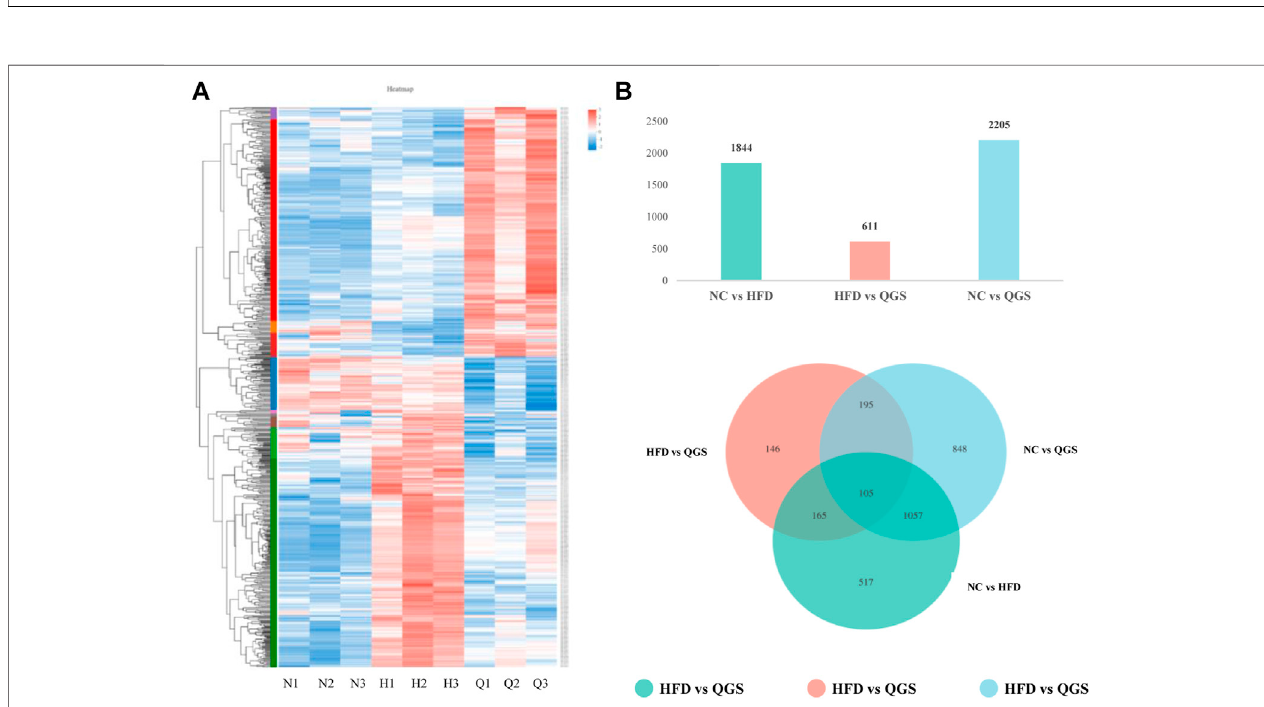
FIGURE 4 | Differential expression gene analysis. (A) Hierarchical clustering. Red represents high expression of genes, while blue represents low expression of genes. The left part is a dendrogram of gene clustering, and the lower part is the name of the sample (N, NC group; H, HFD group; Q, QGS group). (B) The upper panel presents numbers in three pairwise comparisons; the lower panel shows the Venn diagram showing the number of DEGs in the three pairwise comparisons.